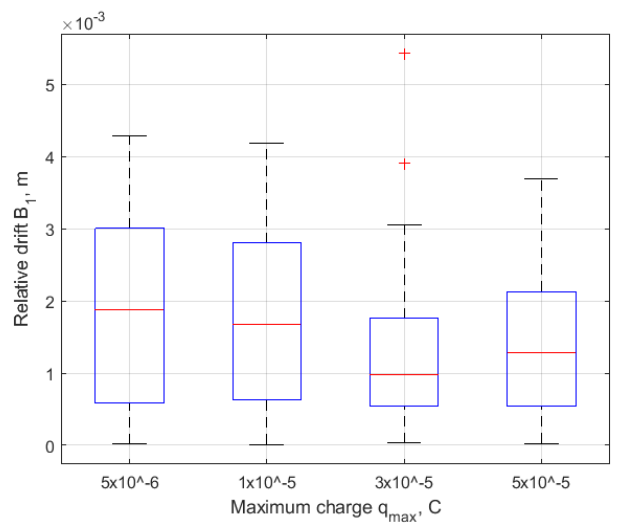
Figure 15. Mean error in B 1 after convergence.